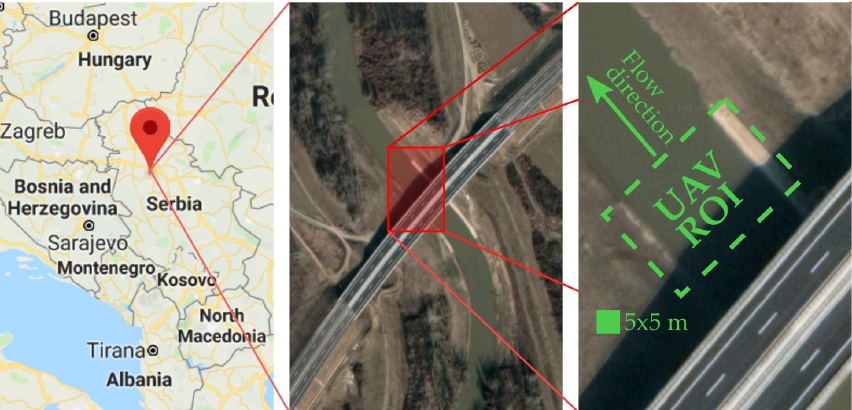
Figure 1. Location and satellite imagery of the study site and Region of Interest (ROI), (C) Google Maps